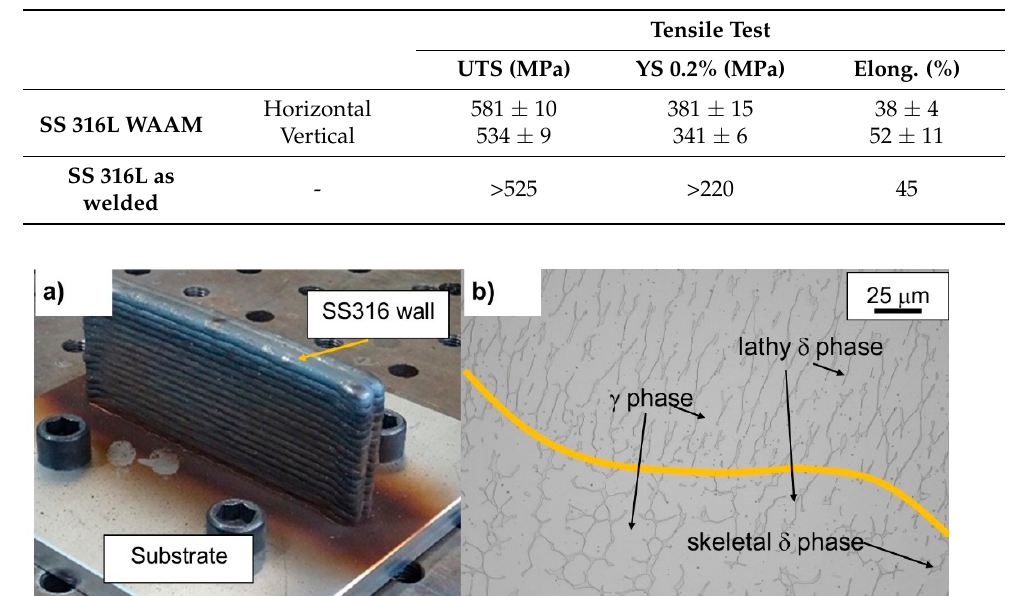
Table 4. Summary comparison of mechanical characterization on PAW-SS 316 wall in different di- rections.